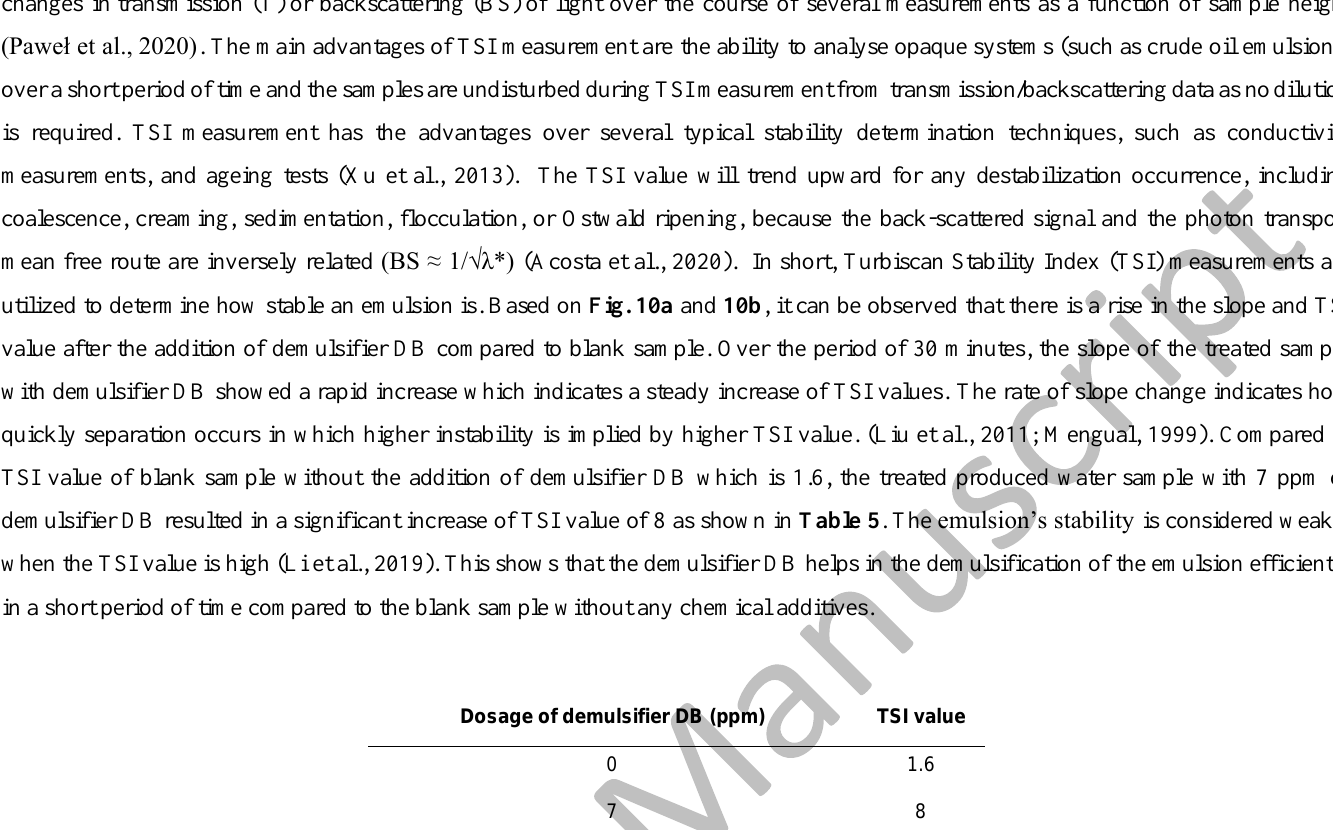
Table 5–Turbiscan analysis of DB demulsifier conducted at 60